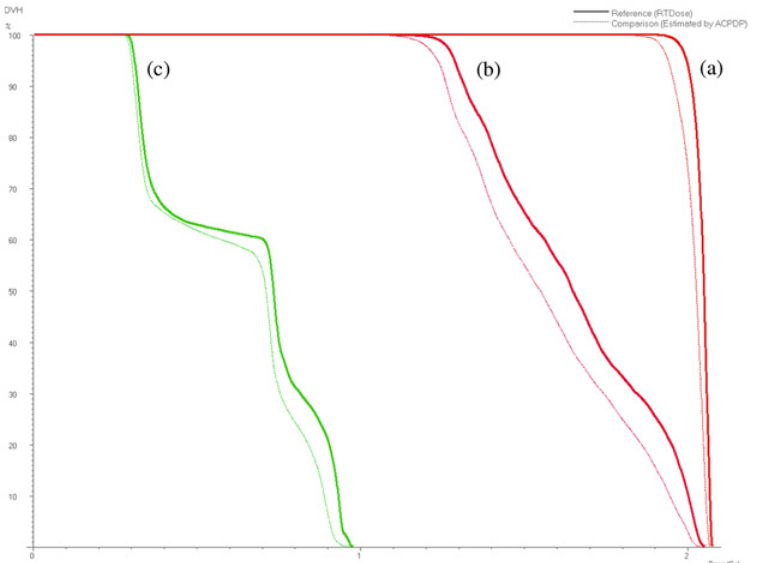
Fig 5. An example of a dose-volume histogram representing the dose distribution for the (a) target, (b) adjacent organ at risk (OAR), and peripheral OAR. The treatment planning system (TPS)-planned doses are plotted as solid lines. The dashed lines represent the 3DVH software- predicted dose, which was calculated on the basis of the ArcCHECK data.